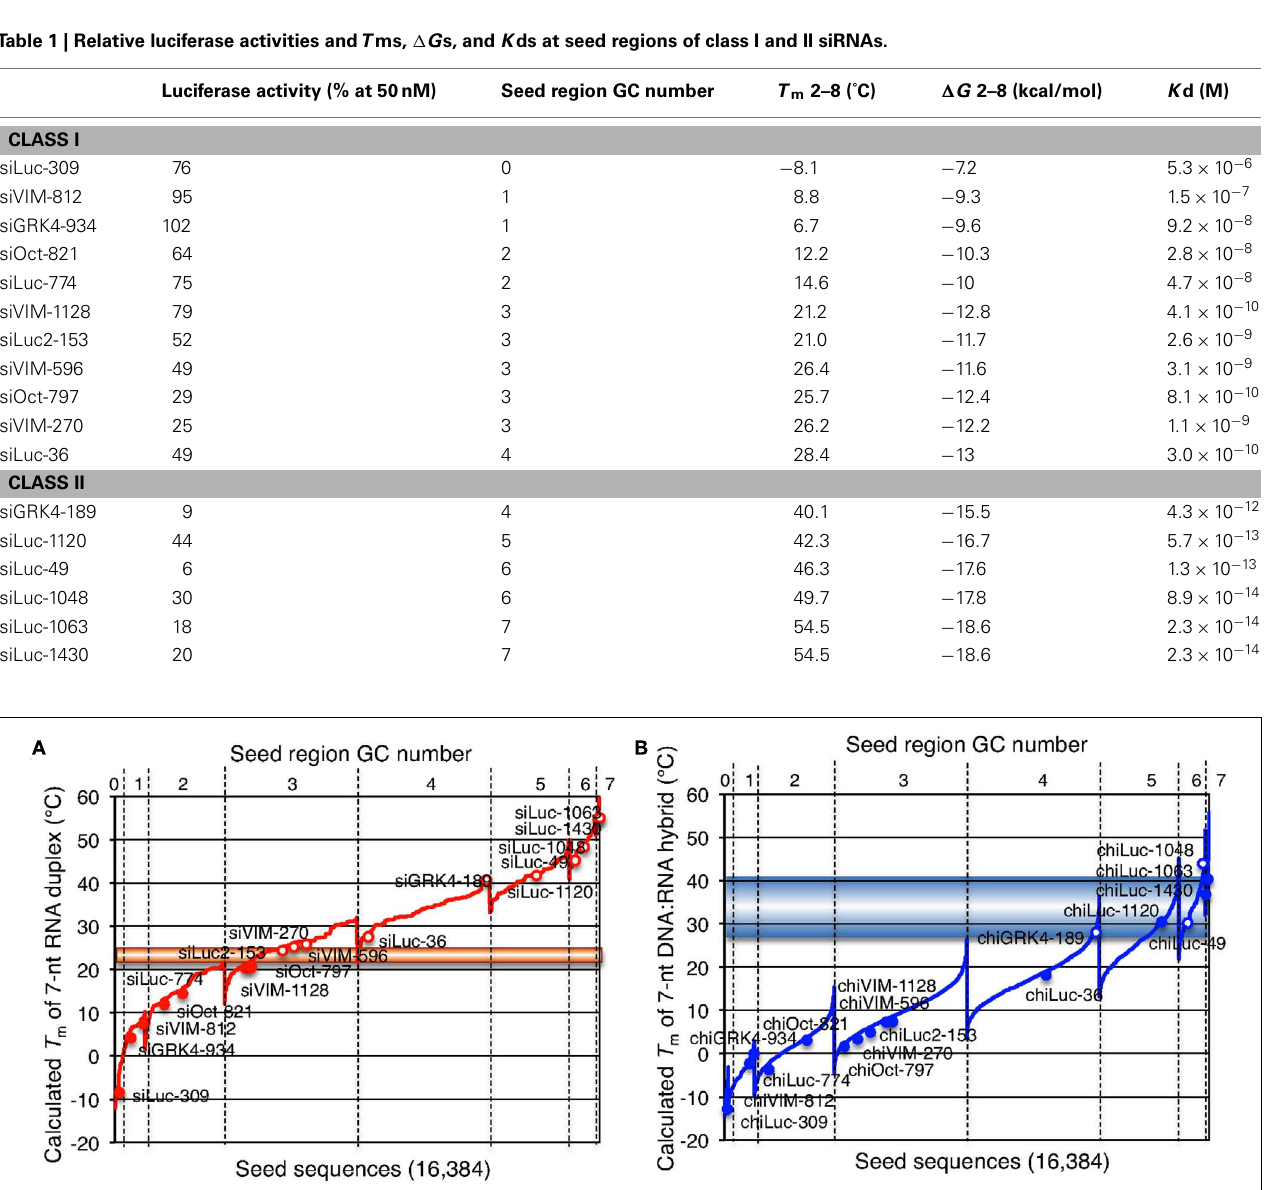
FIGURE 6 | Correlation between seed-dependent gene silencing activity of siRNA and chiRNA and calculated T m of the protein-free seed duplex. Gene silencing activity was measured using relative luciferase activity in HeLa cells transfected with psiCHECK-sm and cognate siRNAs or chiRNAs at a 50nM concentration, as shown in Figures 4 and 7 . T m of the protein-free seed region (positions 2–8) was determined using the nearest neighbor method. (A,B) All possible 7-nt seed sequences (4 7 = 16,384) were ordered as a function of GC content